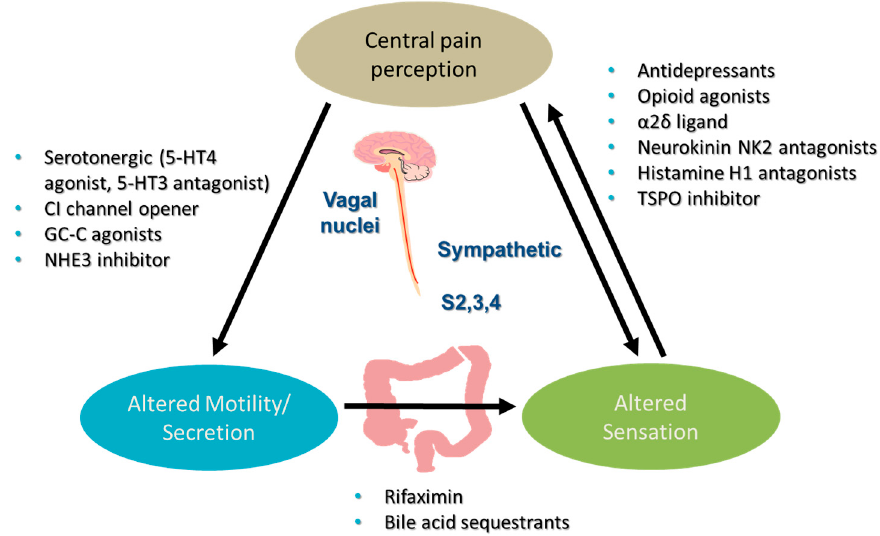
Figure 1. Pharmacotherapy in Irritable Bowel Syndrome. 5-HT = 5-hydroxy tryptamine; GC-C-guanylate cyclase C; NHE = sodium-hydrogen exchanger; S2, 3, 4 = sacral nerves 2, 3 and